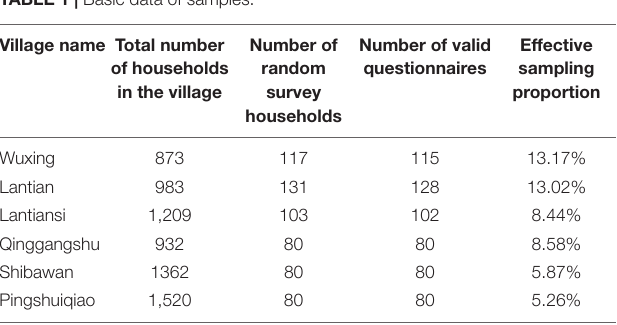
TABLE 1 | Basic data of